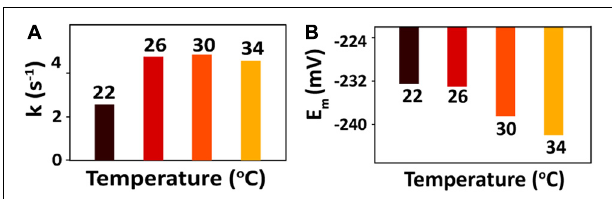
FIGURE 7 | (A) Calculated rate constants for AQS bioreduction at different temperatures. (B) CV midpoint potentials ( E m ) of AQS at different temperatures.